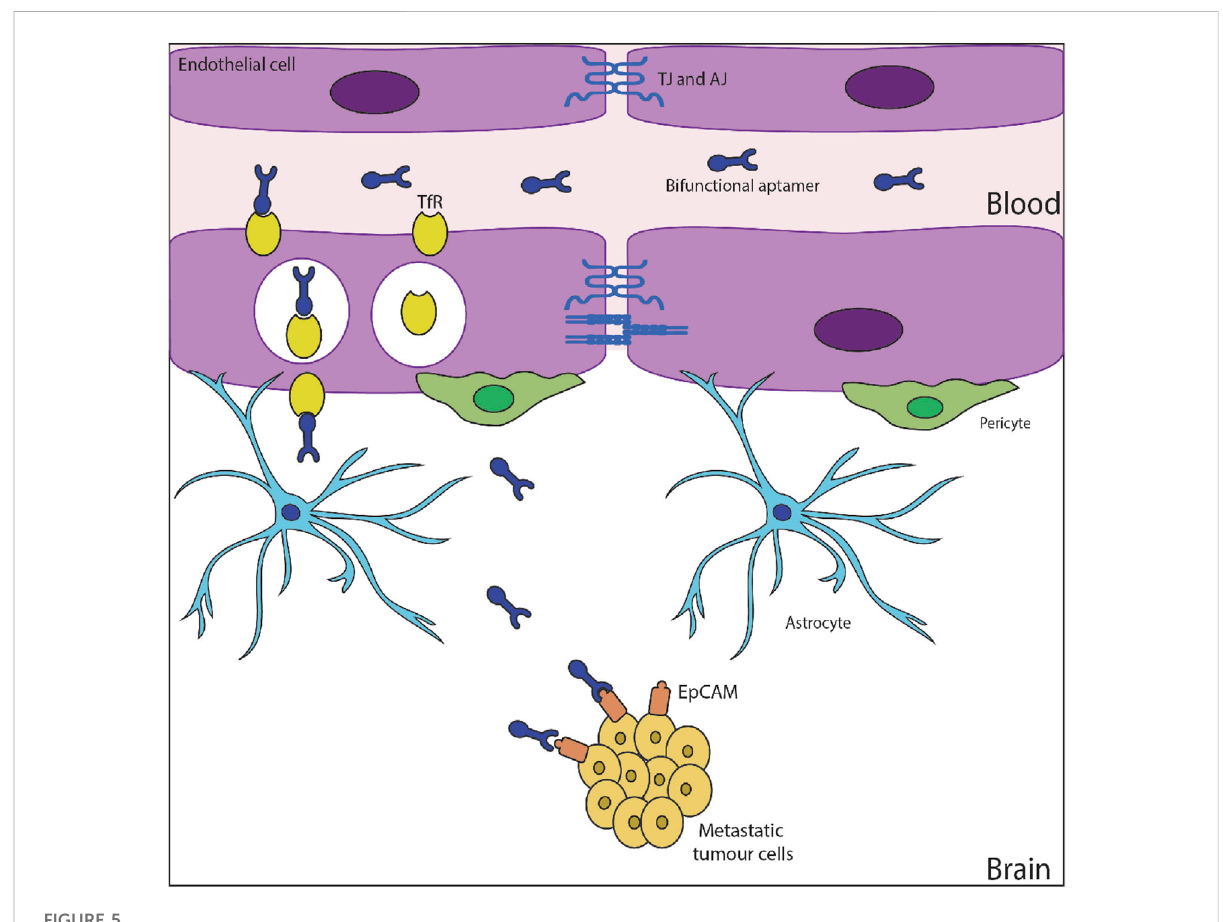
FIGURE 5 Apatmertranscytosisandreleaseintobrainmicroenvironment(Macdonaldetal.,2018)underCreativeCommonsAttributionNon-Commercial License